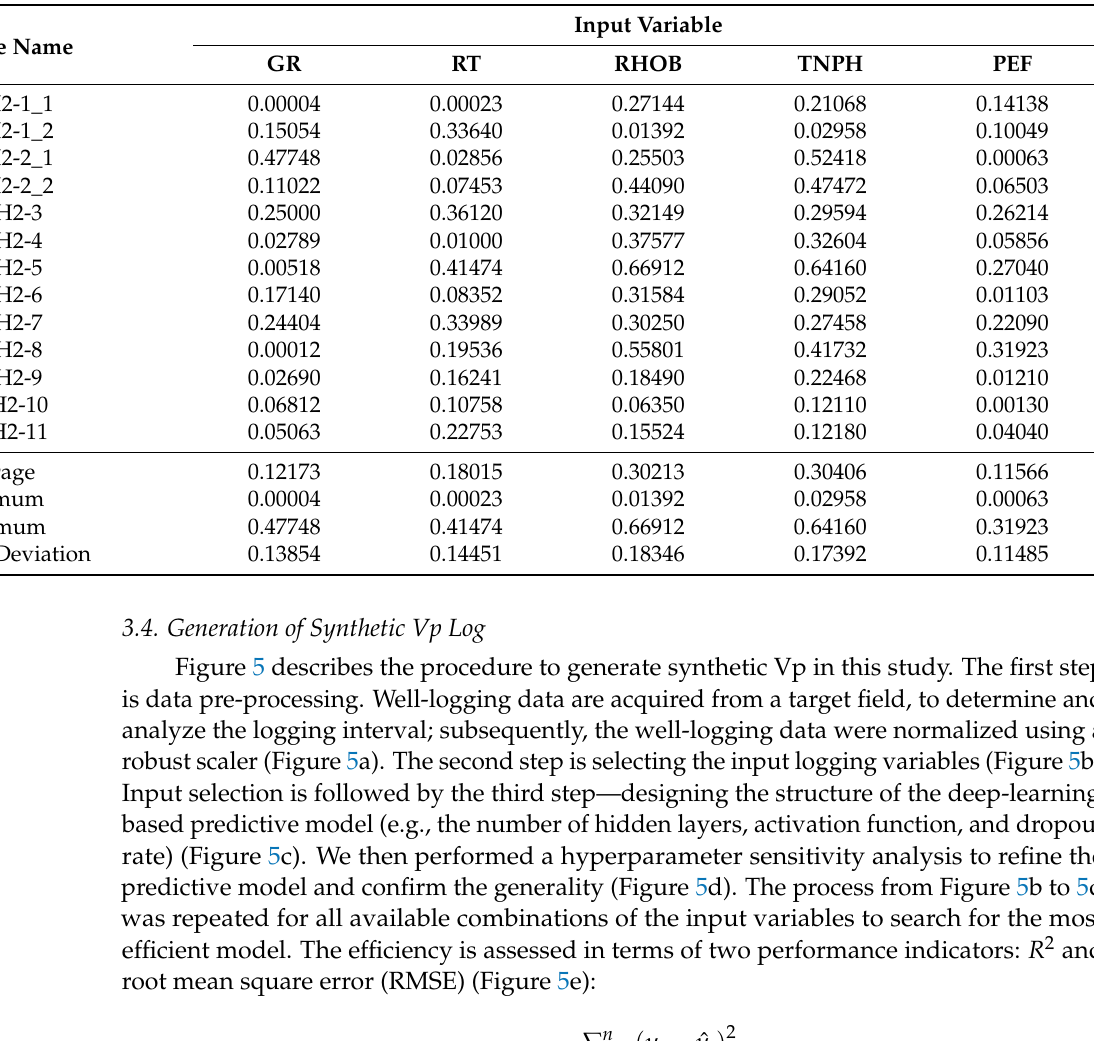
Table 1. Coefficient of determination between the input variable and Vp in each